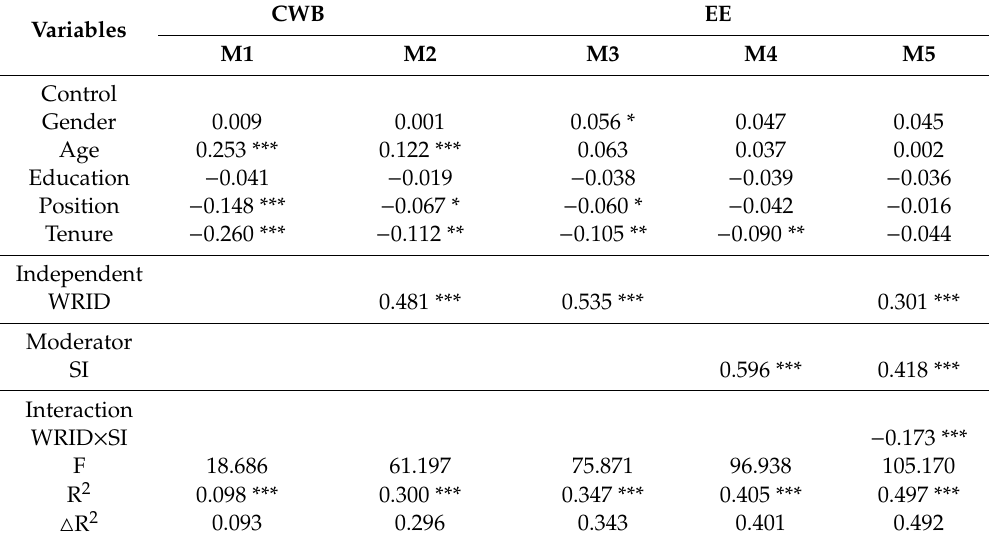
Table 3. The main and moderating e ff ects (N =